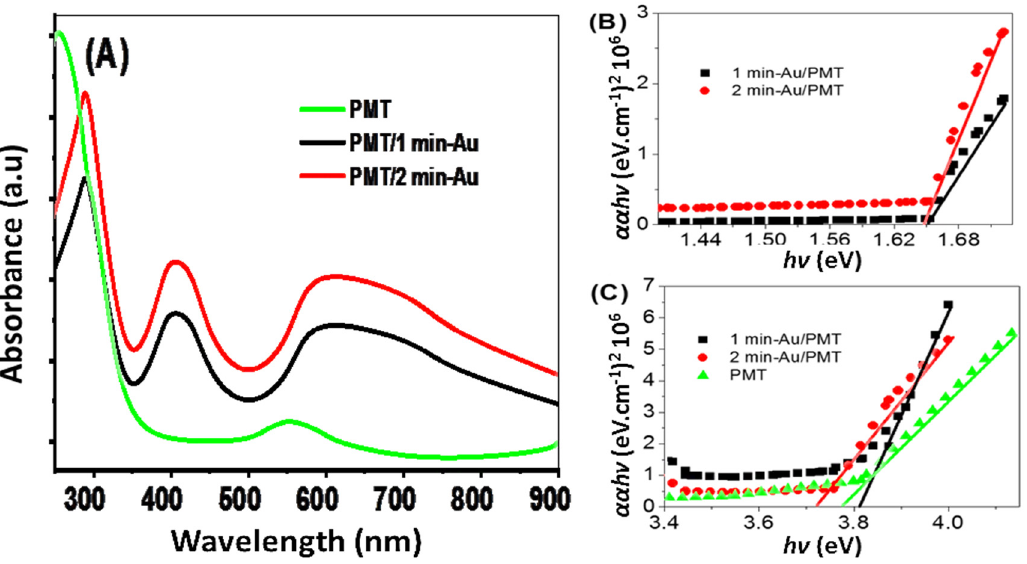
Figure 5. ( A ) The optical absorbance and ( B , C ) bandgap values for the PMT, PMT/Au-1 min, and PMT/Au-2 min nanomaterials. PMT/Au-2 min